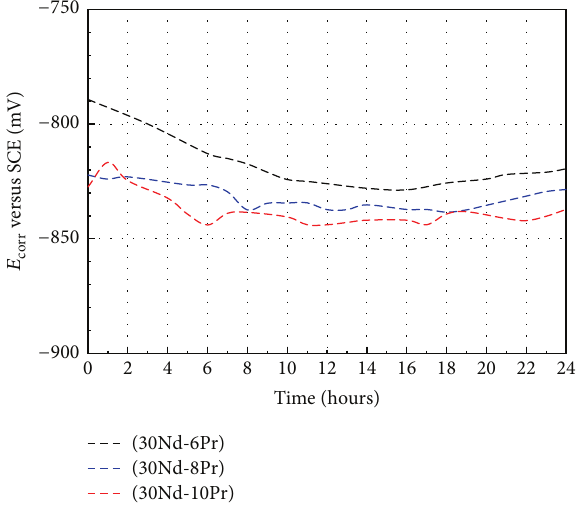
Figure 6: Variation of 𝐼 corr values for NdPr magnets tested in 3.5% NaCl solution at 25 ∘ C for 24